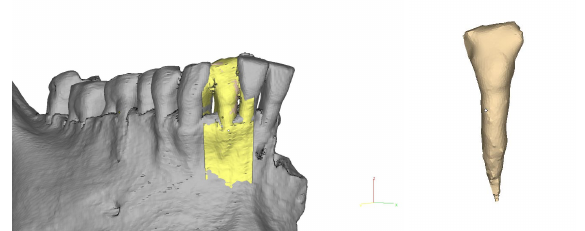
Figure 7. Segmentation of the incisor fragment from the 3D image (left) and the segmented incisor (right)